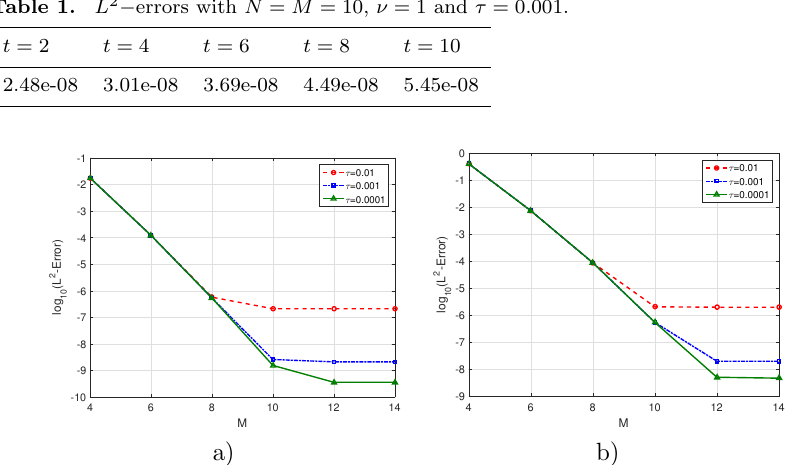
Figure 2. L 2 − errors against M , N ( M = N ) with t = 1: a) ν = 1, b) ν = 0 . 001.